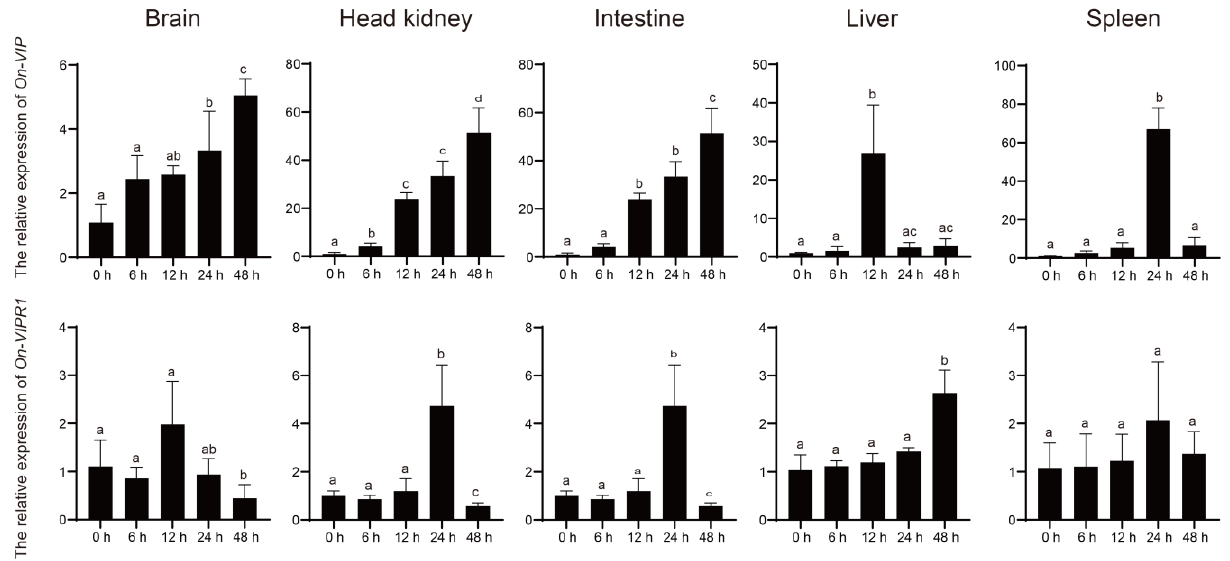
Figure 3. The transcriptional levels of On-VIP and On-VIPR1 in the liver, head kidney, brain, spleen, and intestine of tilapia infected with S. agalactiae at various time points via qRT-PCR. The transcriptional levels of On-VIP and On-VIPR1 at 0 h were set as 1. Every value was presented as the mean and standard deviation; n = 3. The different letters were applied to reveal the significant difference ( p < 0.05).